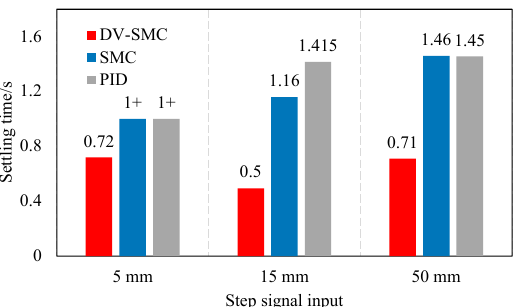
Figure 9. Settling time of different control strategies. 1+ in Figure 9 represents that the settling time of SMC and PID on the 5 mm step input is longer than the signal collecting time (1s).